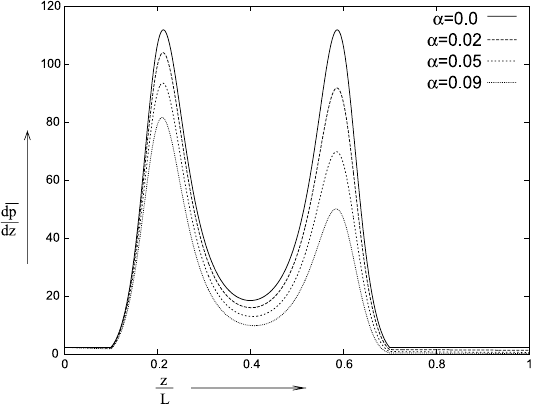
Fig.12. Variationofpressuregradient( of α when H = 0 . 2, M = 2 . 5, β = 2 . 5, and k = 0 .